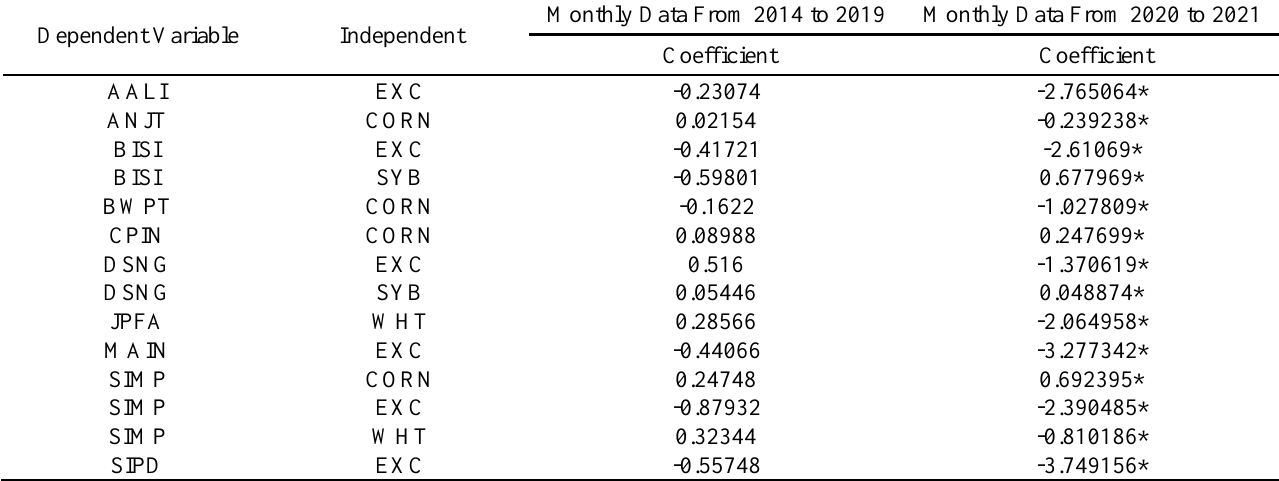
Summary of GARCH (1,1) Output (Pandemic)